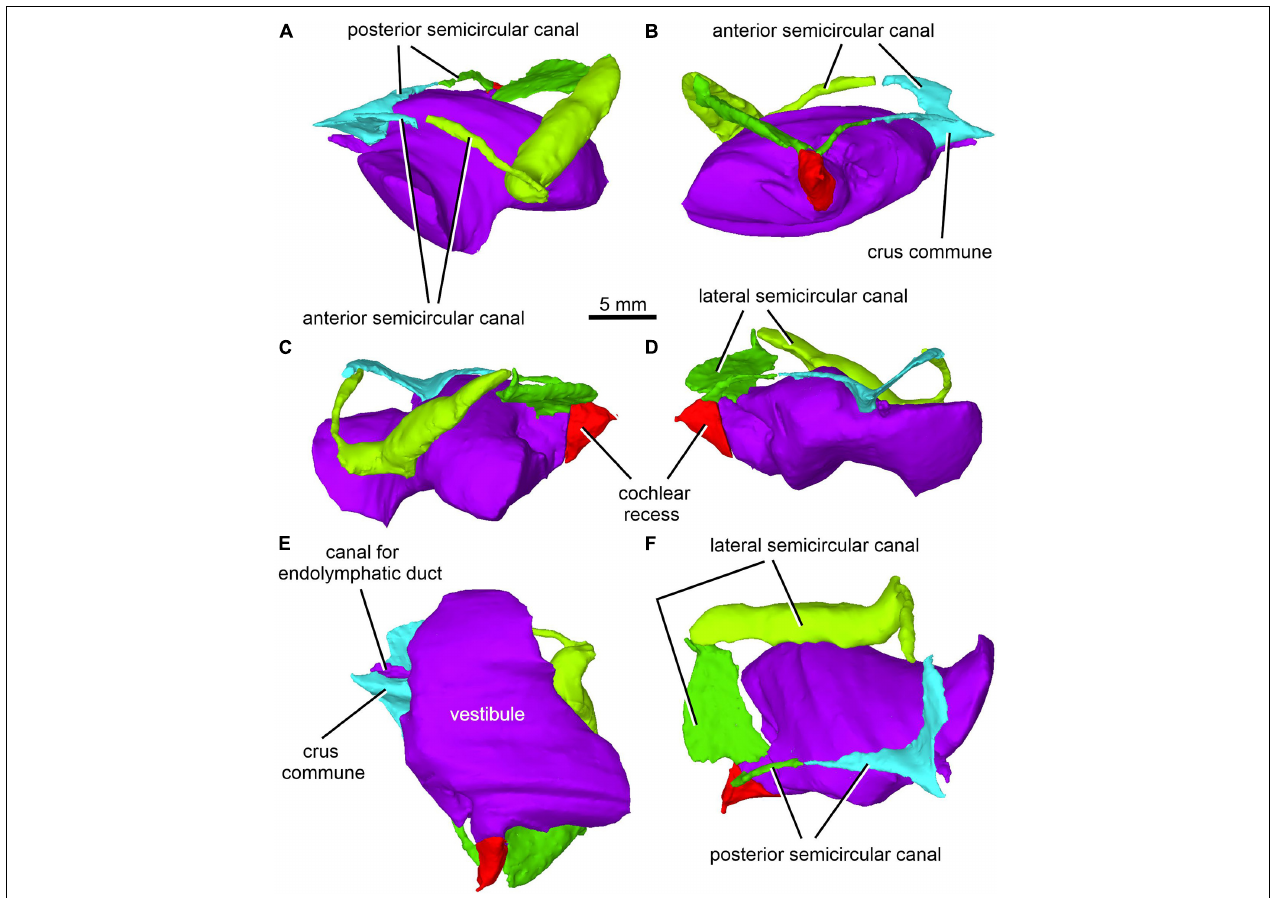
FIGURE 13 | Limnoscelis dynatis , CM 47653. Virtual 3D model of inner ear in anterior (A) , posterior (B) , left lateral (C) , right lateral (D) , ventral (E) and posterodorsal (F) views.